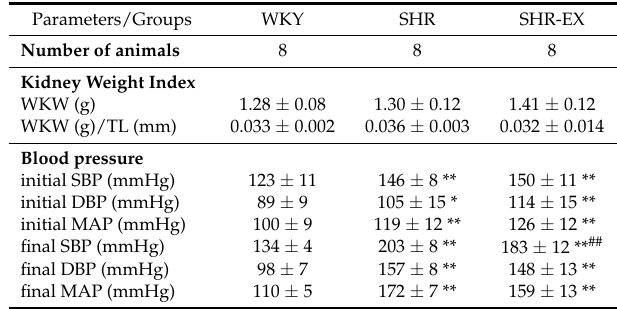
Table 1. Cardiac characteristics of WKY, SHR-Sham, and SHR-EX